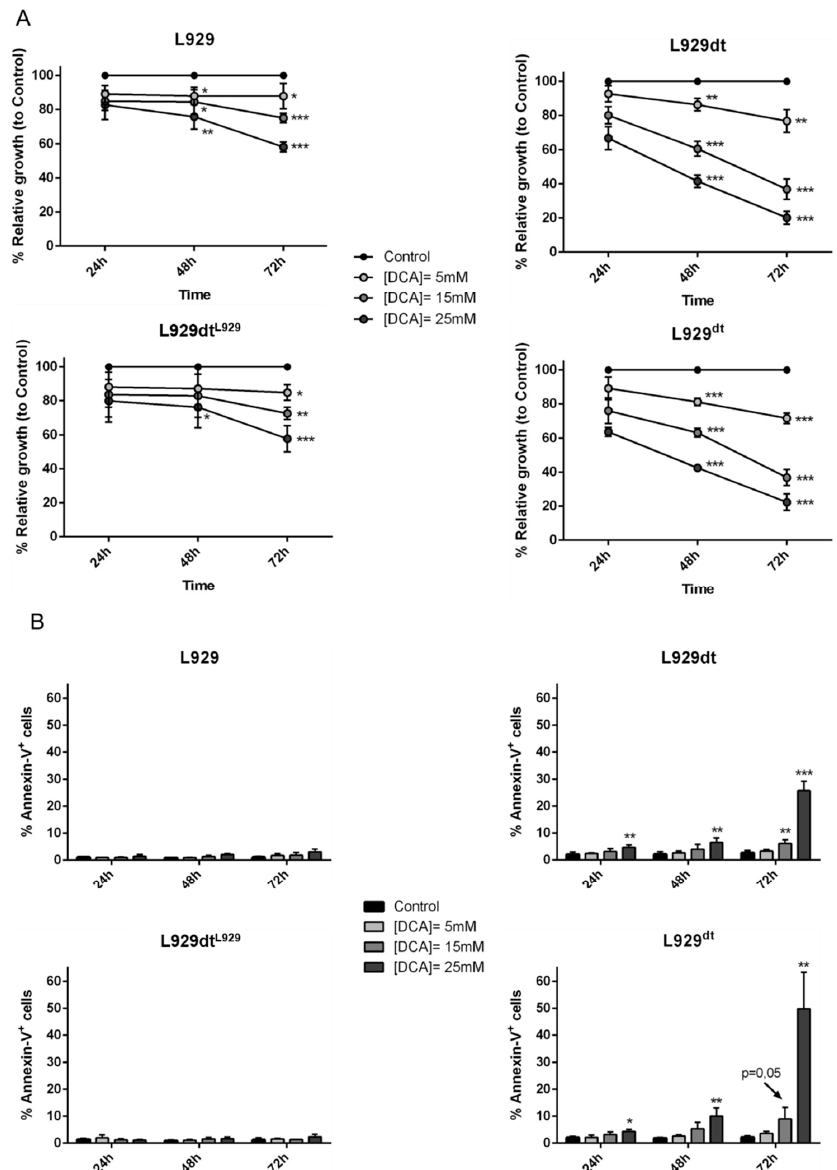
Figure 8. Effect of DCA on cell growth and cell death of the different cell lines studied. ( A ) Cells were supplemented or not (Control) during 72 h with the indicated concentrations of DCA, and every 24 h, cell growth was determined by the MTT reduction method and results expressed as percentage of cell growth relative to control cells. Results are the mean ± SD of three different experiments. *, p < 0.05; **, p < 0.02; ***, p < 0.01. ( B ) Cells were supplemented or not (Control) during 72 h with the indicated concentrations of DCA. Then, cells were stained with annexin-V-FITC and PS exposure, as a marker of apoptosis induction, was analyzed by flow cytometry. Results are the mean ± SD of three different experiments. *, p < 0.05; **, p < 0.02; ***, p < 0.01.